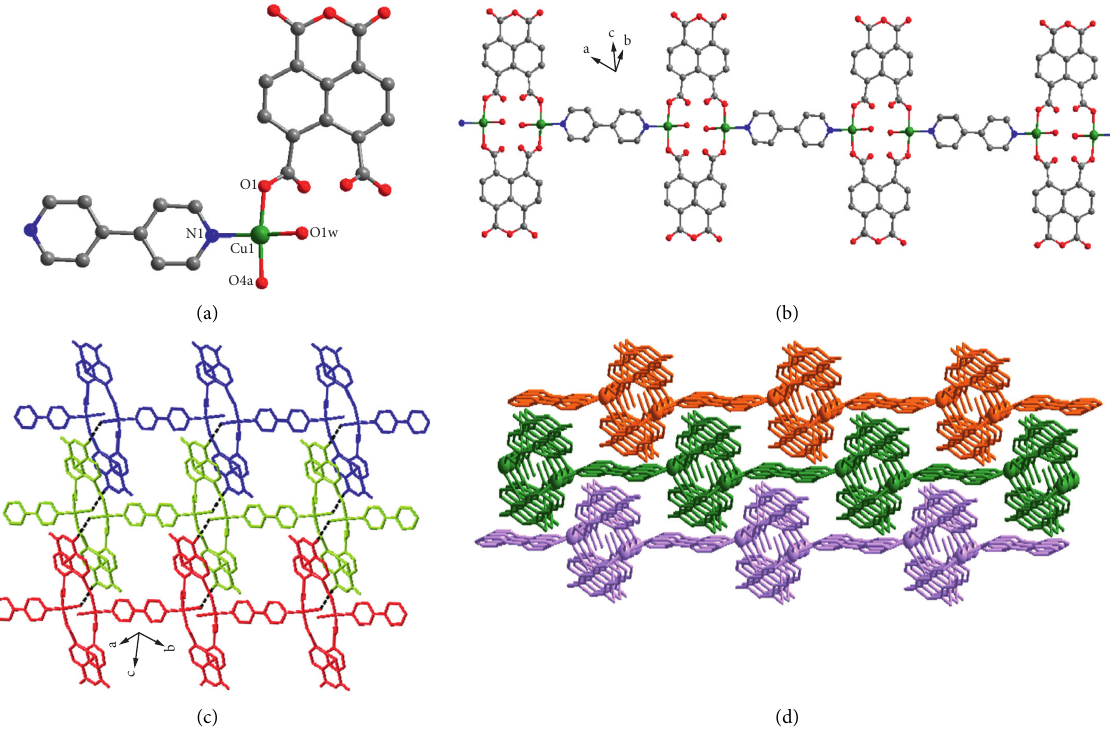
Figure 1: (a) Cu(II) ion coordination map in 1 . (b) one-dimensional infinite chain structure of 1. (c) two-dimensional supramolecular layer via the linkage of interchain hydrogen bonds for 1 (dotted lines are the hydrogen bonds). (d) stacked 3D supramolecular framework for 1 directed by weak Van der Waals interactions.